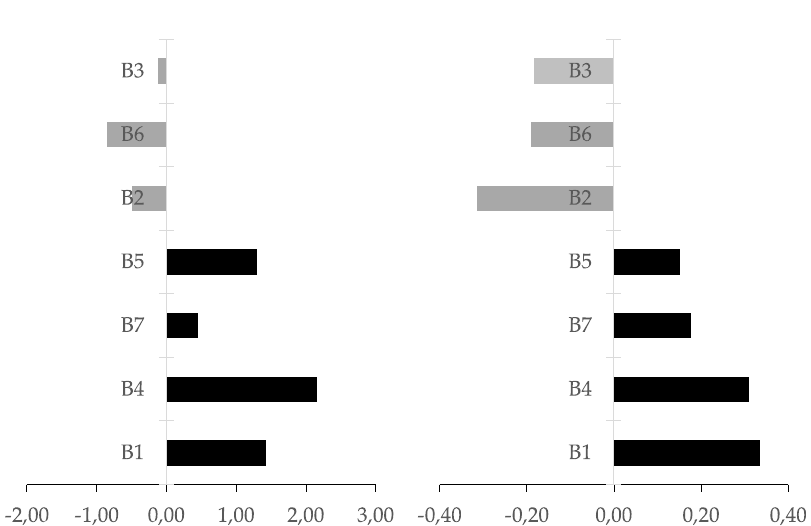
Figure 4. Bar chat of the deviation normalized from the average for each genetic line in terms of boar effect in farrowing rate and litter size.